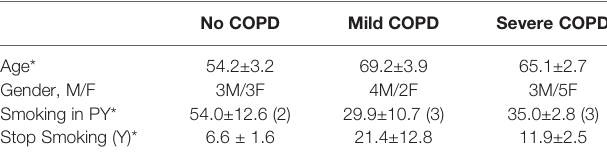
( Figure 1D ) with 7.9-fold higher percentage of MUC5AC-positive (MUC5AC + ) cells observed in CS macaques over FA group ( Figure 1E ). Thus, chronic CS exposure results in goblet cell hyperplasia with increased expression of MUC5AC